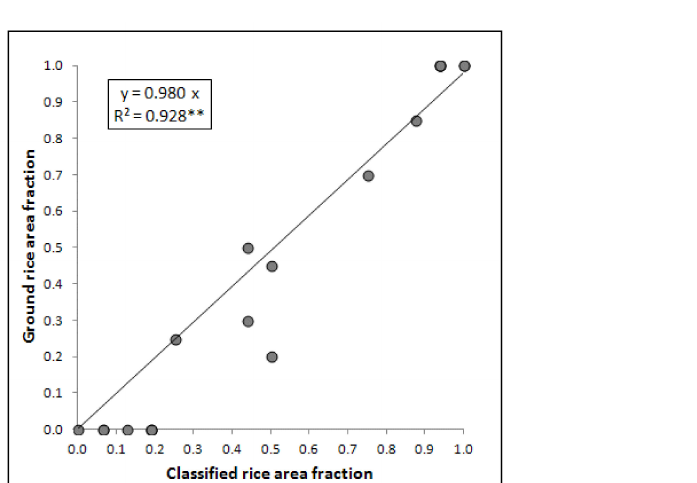
Figure 13. Linear regression forced through the origin of the rice area fractions measured on the ground and derived from the RF classification for the 20 40 × 40 m 2 plots (** = highly significant correlation, p <